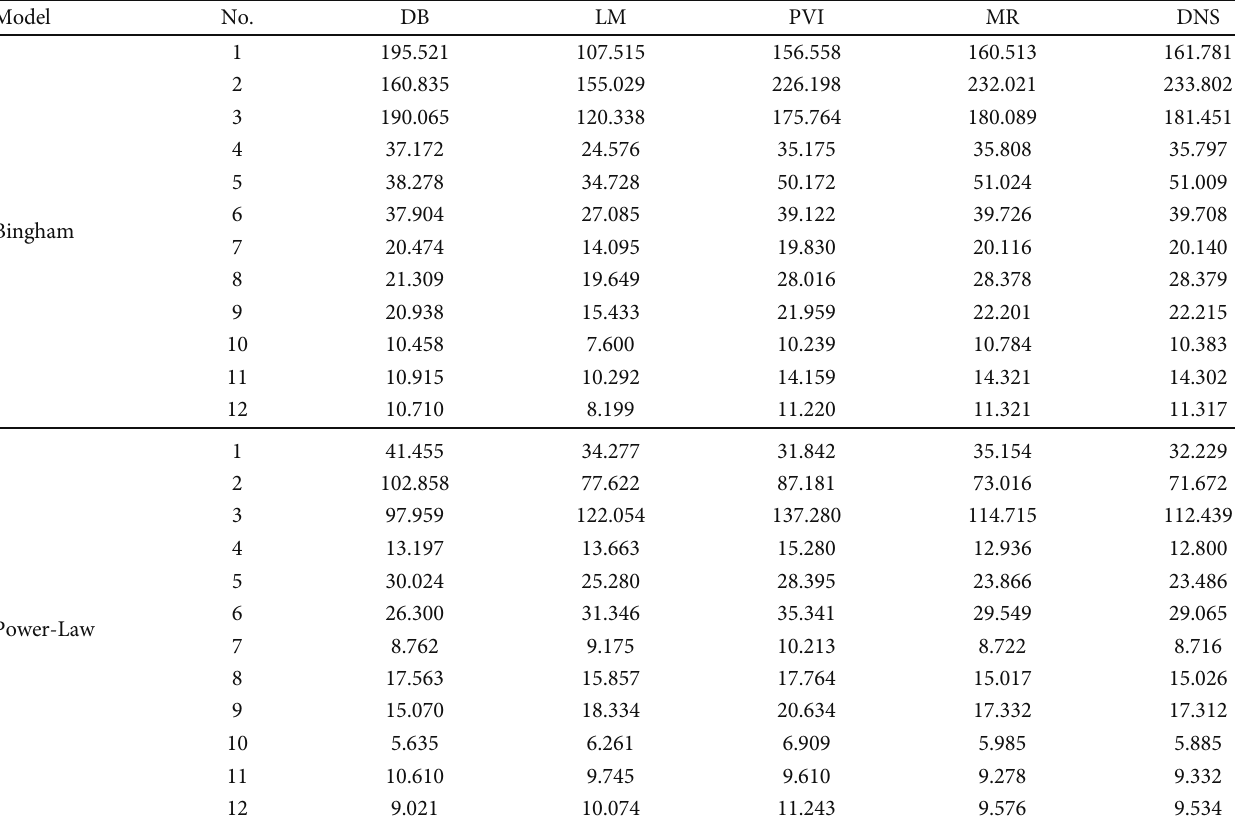
Figure 4: Comparison of the cementing ECD calculated by using the Bingham and Power-Law rheological Table 4: Comparison of the ECD results calculated by fi ve methods.